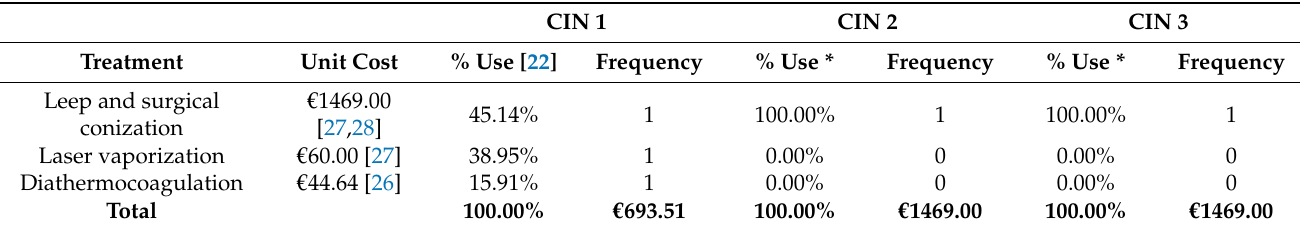
Table 4. Unit cost of therapeutic alternatives for the management of HPV-related lesions and percentage of use per treatment by degree of lesion.